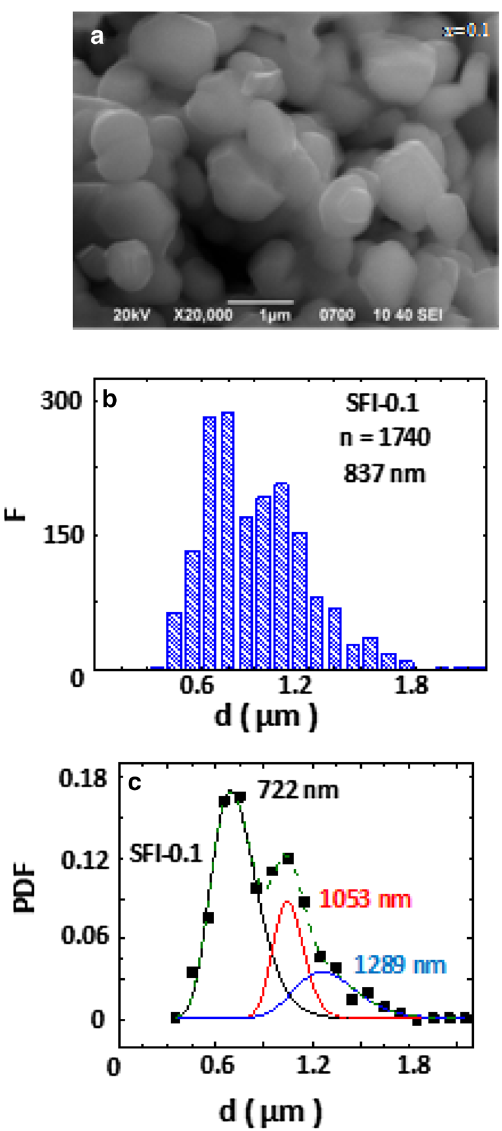
Figure 2. Surface morphology for the SFI-0.1 sample ( a ), the distribution histograms vs. particle diameter ( b ) and the approximation of the average probability density by the three-modal function of the lognormal distribution ( c